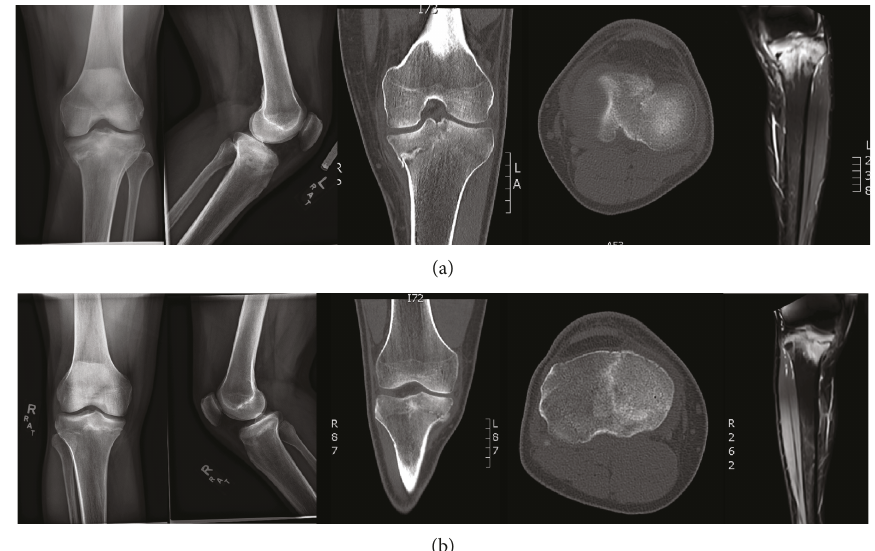
Figure 1: (a) Radiograhps, CT scan, and MRI of the left knee at the time of presentation demonstrate varus malalignment with medial sided proximal tibia stress fracture with extension to the articular surface and articular surface collapse. (b) Radiographs, CT scan, and MRI of the right knee demonstrate varus malalignment with medial sided tibia stress fracture without articular collapse.